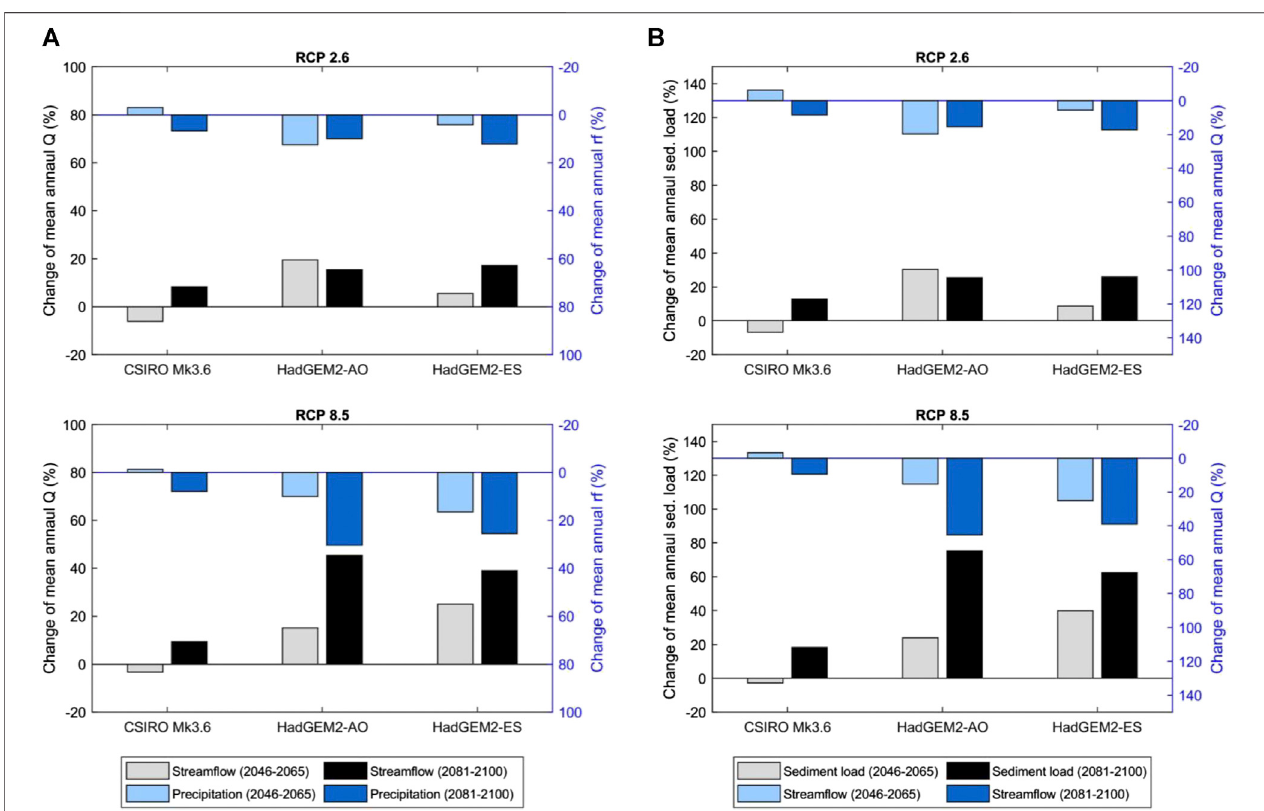
FIGURE 5 | Percentage change of projected mean annual fl ow (A) and sediment load (B) at Pyay relative to the baseline period (1991-2005) under RCP 2.6 and RCP8.5 computed using the three selected GCM data as forcing. Q is Stream fl ow and rf is precipitation. Each panel (A , B) show results for RCP 2.6 (top) and RCP 8.5 (bottom) andthethreeselectedGCMs(CSIRO Mk3.6,HadGEM2-AO,and HadGEM2-ES).Ineach plot,lightcolorbar showsresultsrelevanttothemid-centuryperiod (2046-2065), whereas dark color bar shows results relevant to end-century (2081-2100). In the Panel (A) , stream fl ow changes are in the primary axis (left Y-axis) and precipitation changes are in the inverse secondary axis (right Y-axis). Similarly, in the Panel (B) , sediment load changes are in the primary axis and stream fl ow changes are in the inverse secondary axis.